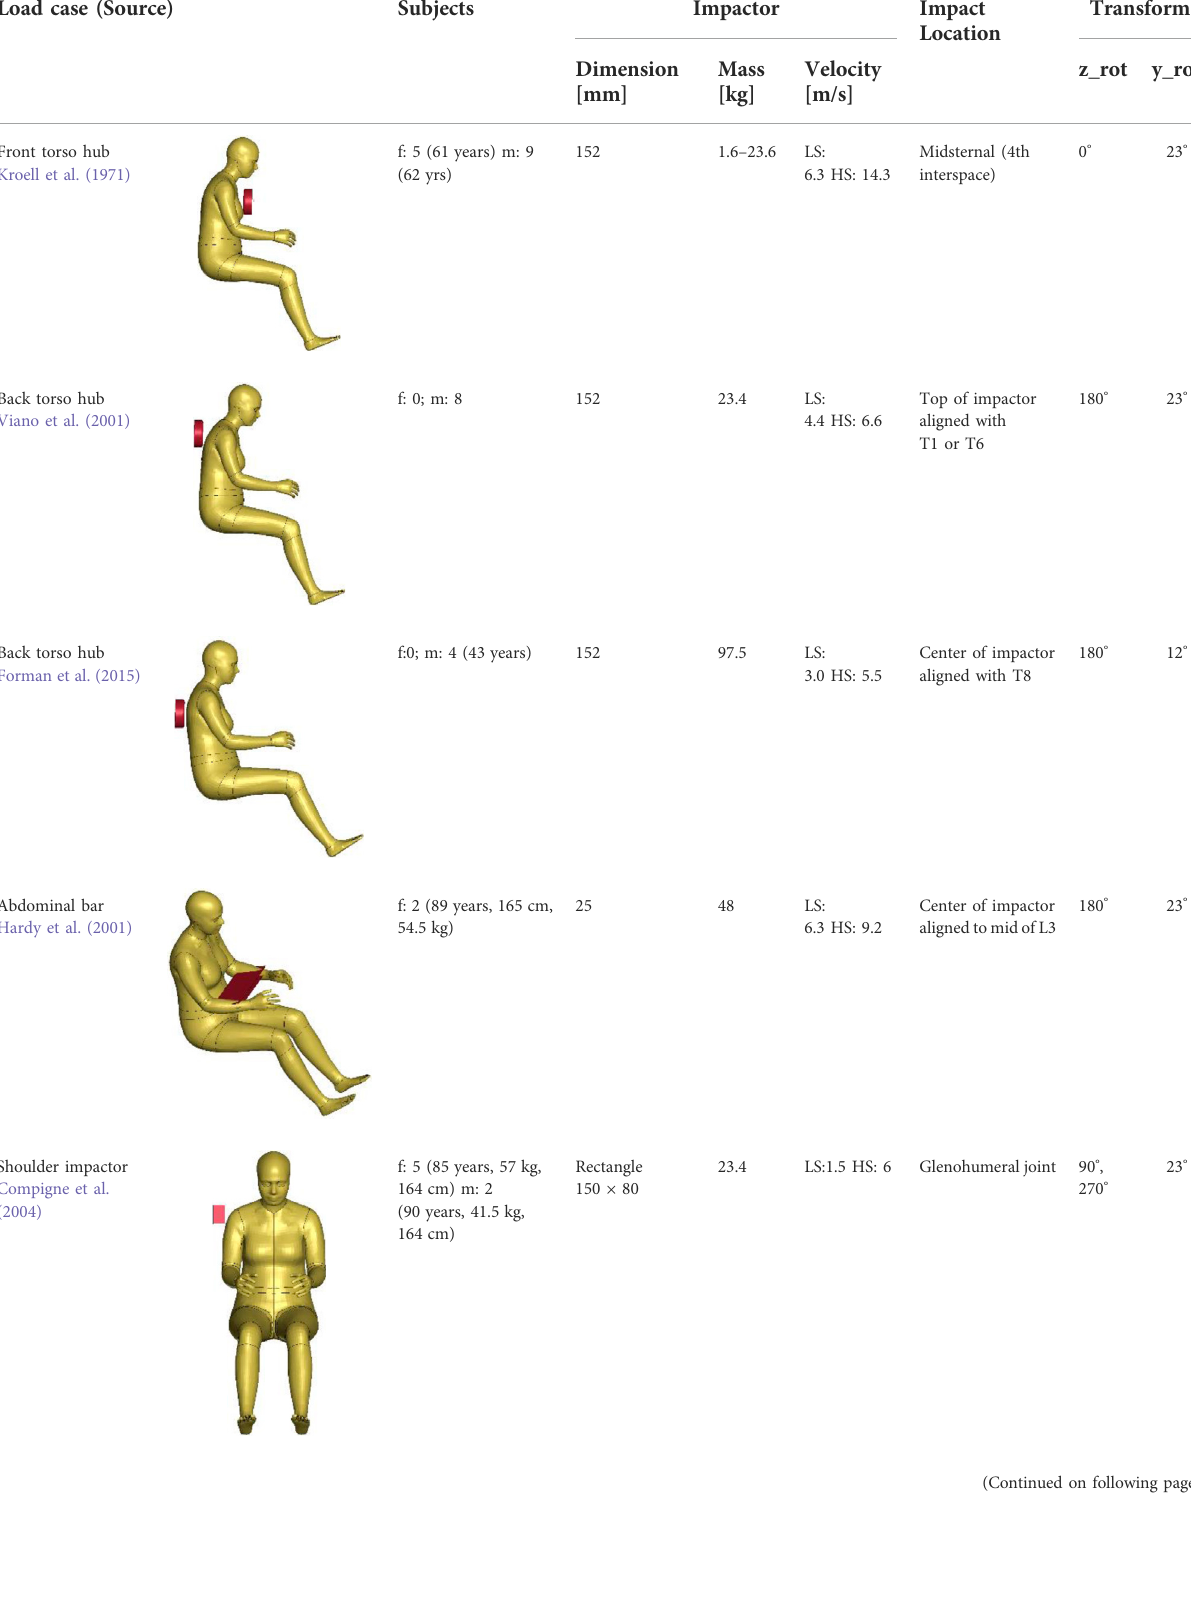
TABLE 1 Hub Impacts used for kinematic and kinetic evaluation (average age, stature, and mass of the subjects are given when available in the literature). The rigid transformation of the HBMs before impact is given in the last two columns. In the velocity column, LS means low speed, MS medium speed and HS high